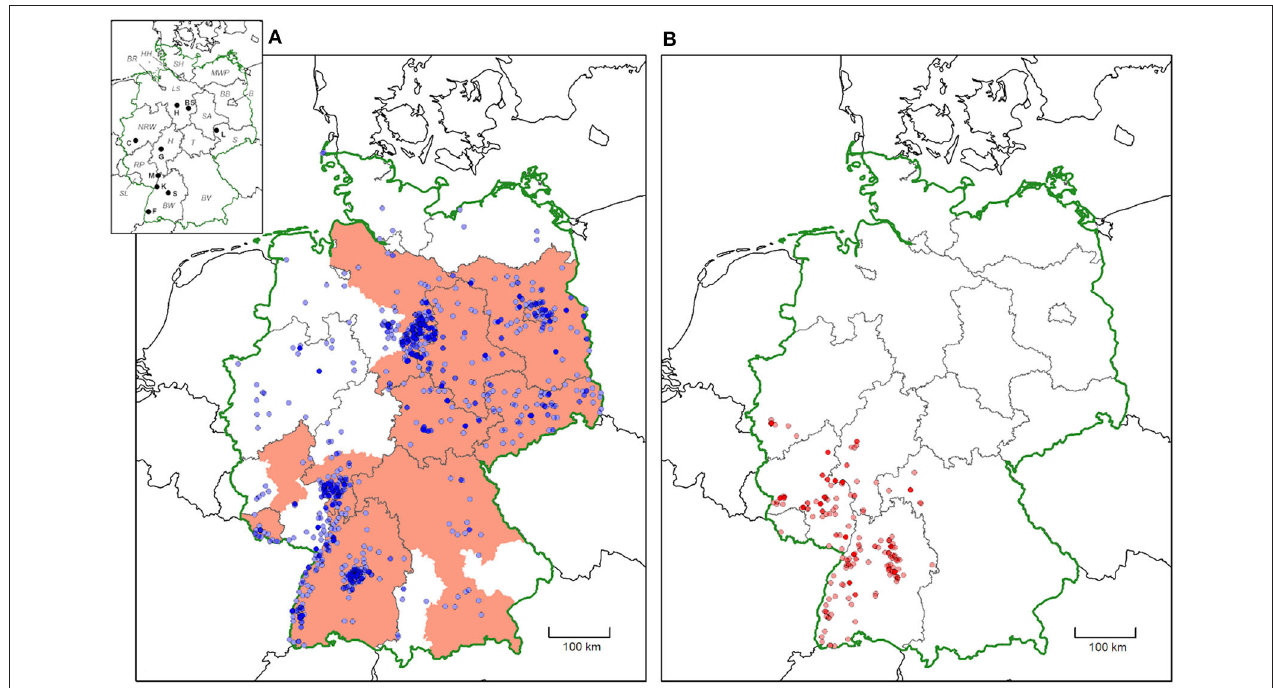
FIGURE 1 | Distribution of Dermacentor reticulatus (A) and Dermacentor marginatus (B) in Germany based on ticks submitted by German citizens from February 2019 to February 2020. Only locations with medium to high accuracy are shown ( D. reticulatus : N = 1,744/3,287, D. marginatus : N = 450/604). More intense colors indicate multiple findings in close proximity. Red shaded areas in (A) represent areas of D. reticulatus distribution as reported by the European Centre for Disease Prevention and Control (ECDC) in July 2019 (https://www.ecdc.europa.eu/en/publications-data/dermacentor-reticulatus-current-known-distribution-july-2019) for comparison. In the map insert, federal states are abbreviated with italic letters (B, Berlin; BR, Bremen; BW, Baden-Wuerttemberg; BV, Bavaria; BB, Brandenburg; HH, Free and Hanseatic City of Hamburg; H, Hesse; LS, Lower Saxony; MWP, Mecklenburg-Western Pomerania; NRW, North Rhine-Westphalia; RP, Rhineland-Palatinate; S, Saxony; SA, Saxony-Anhalt; SH, Schleswig-Holstein; SL, Saarland; T, Thuringia). Cities are abbreviated with bold letters (BS, Brunswick; C, Cologne; F, Freiburg; G, Gießen; H, Hanover; K, Karlsruhe; L, Leipzig; M, Mannheim; S,